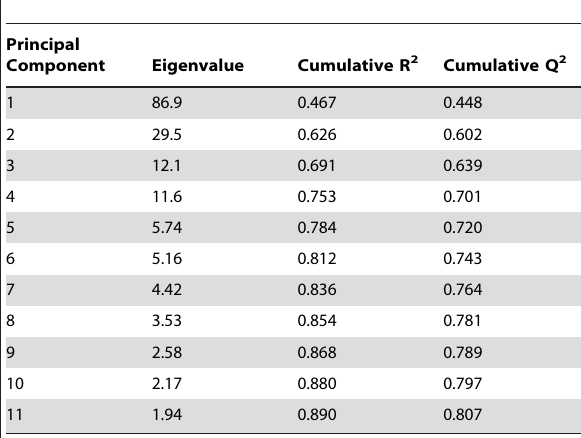
Table 3. Summary of the PCA-analysis of the original descriptors, describing the eigenvalues of the covariance matrix, the total variance explained (cumulative R 2 ) and the predictive ability (cumulative Q 2